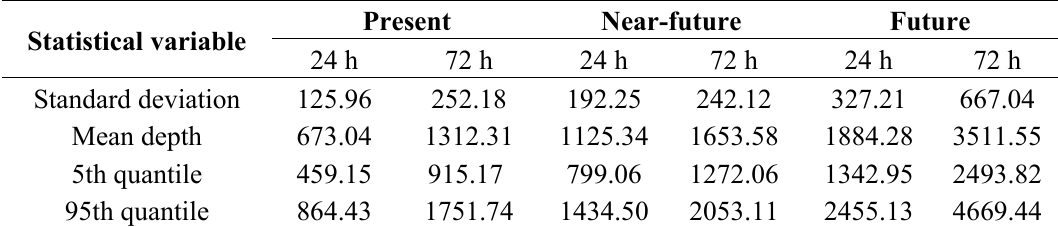
Table 1. Uncertainty of a 100-year return period depth. Unit is